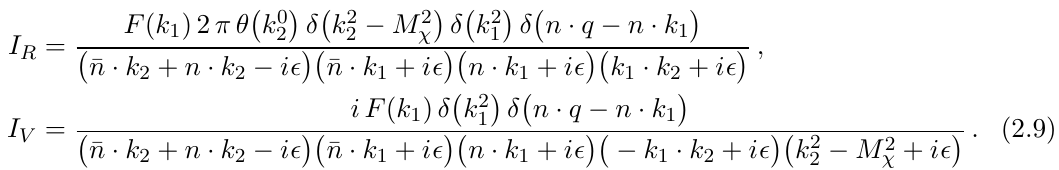
Figure 4 . An illustration of the factorization of soft radiation at the scale m those at the scale M (cid:31) (1 z ) (orange). To prove this factorization at NLL, one must show (cid:0)